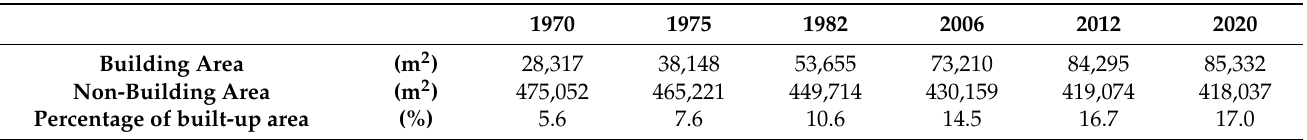
Table 3. Area of “Building” and “Non-building” classes and percentage of built-up area in relation to the whole study area.